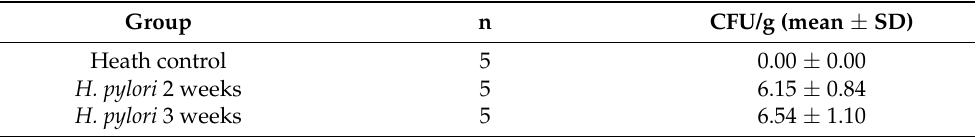
Table 8. H. pylori bacterial count (Colony Forming Units/mL (CFU/g)) in mice stomachs at 14 and 21 days after inoculation and in healthy controls.